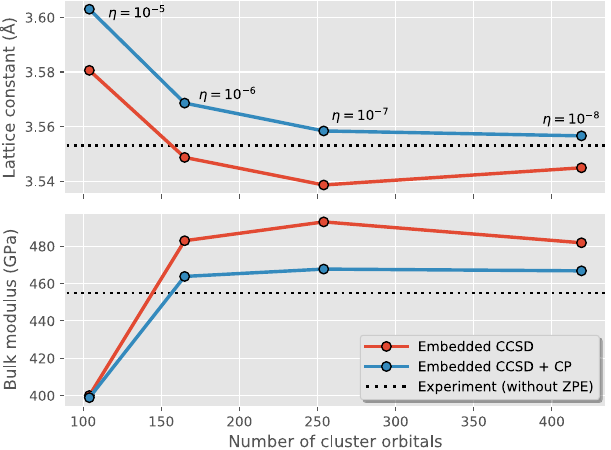
FIG. 9. Uncorrected and CP -corrected equilibrium lattice constant (top) and bulk modulus (bottom) of 5 × 5 × 5 diamond for different values of the bath threshold η . The cc-pVTZ basis set is used, and the experimental values denoted by the black dotted lines are corrected for the effect of zero-point energy.